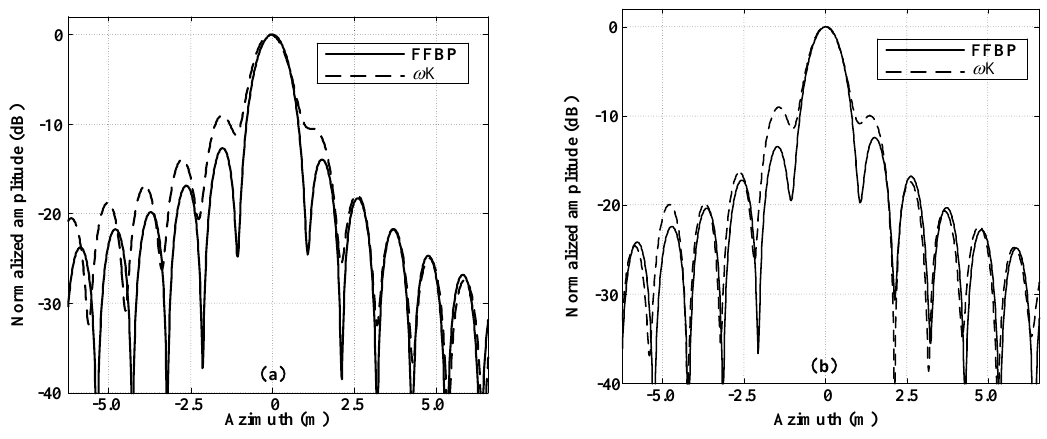
-5.0 Figure 9. Azimuth response comparison of ( a ) the center scatter and ( b ) the edge scatter processed by the proposed FFBP-based motion compensation (solid lines) and the ω K-based motion compensation (dashed